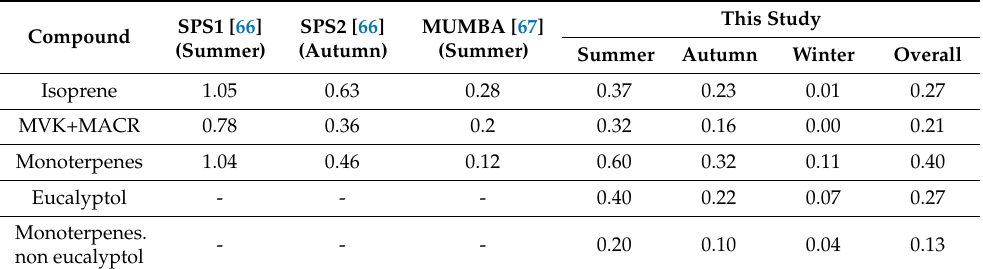
Table 5. Mean BVOC concentrations in ppb during the COALA-JOEYS 2019 campaign compared to previous studies in Australia. MVK = methyl-vinyl-ketone, MACR = methacrolein, Monoterpenes = sum of p-cymene, eucalyptol and α -pinene. Concentrations are in parts per billion. This Study SPS1 [66] SPS2 [66] MUMBA [67] Compound (Summer) (Autumn) (Summer) Summer Autumn Winter Overall Isoprene 1.05 0.63 0.28 0.37 0.23 0.01 0.27 MVK+MACR 0.78 0.36 0.2 0.32 0.16 0.00 0.21 Monoterpenes 1.04 Eucalyptol - - - 0.27 Monoterpenes. - - non eucalyptol